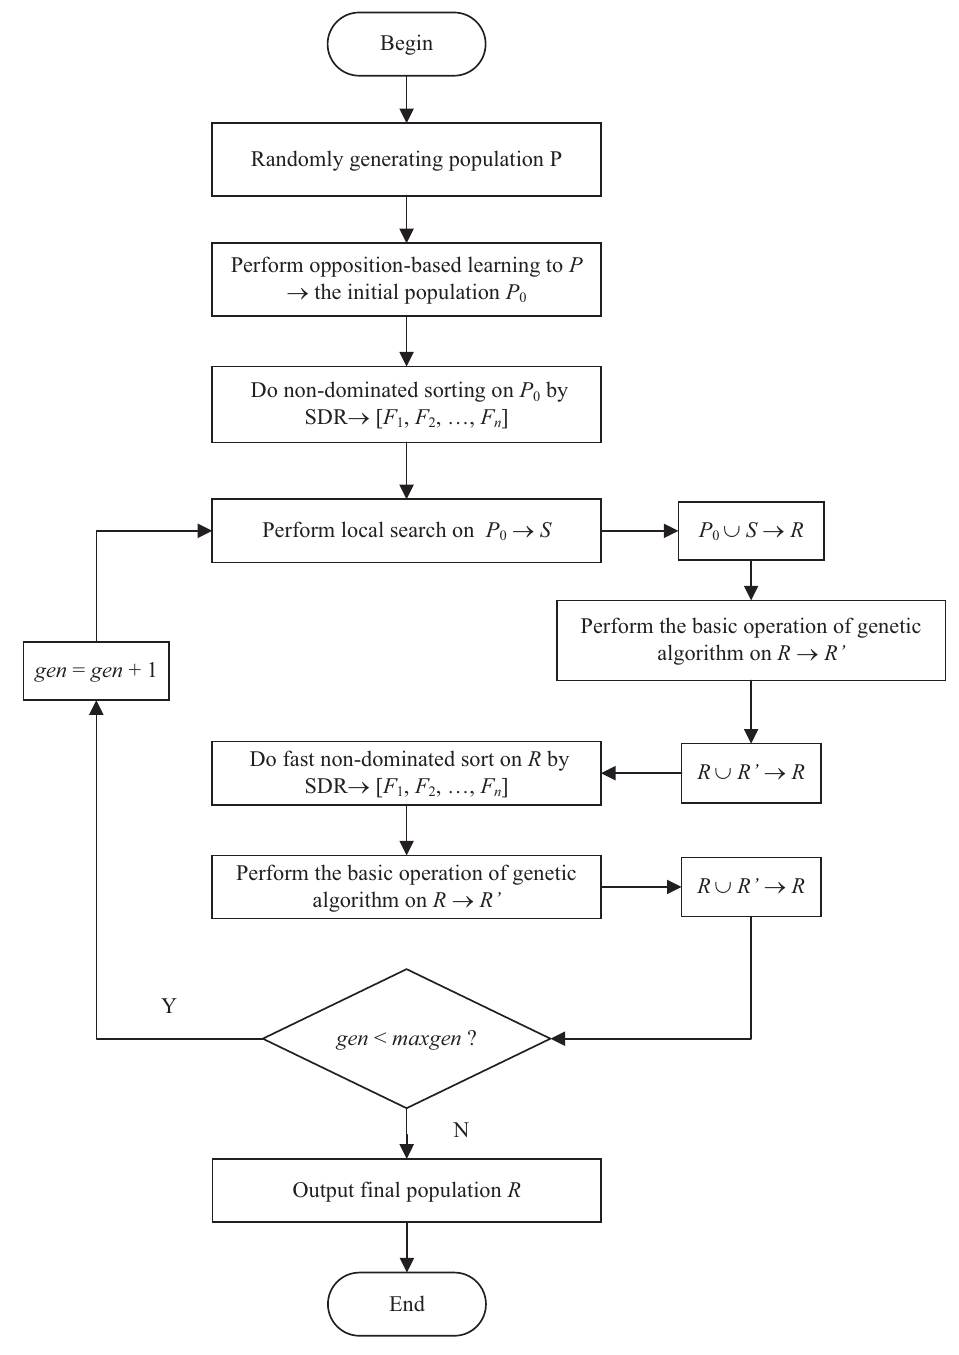
Figure 3. The main process of